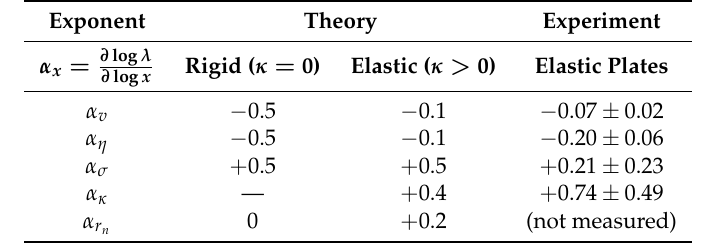
Table 4. Experimental vs. theoretical scaling exponents of the viscous finger wavelength λ ( x ) ∼ x α x , as a function of the printing parameters x : printing velocity v , ink viscosity η , surface tension σ , gap widening coefficient κ , and cylinder radius r n . The theoretical exponents for rigid, i. e. non-deformable plates, are shown for